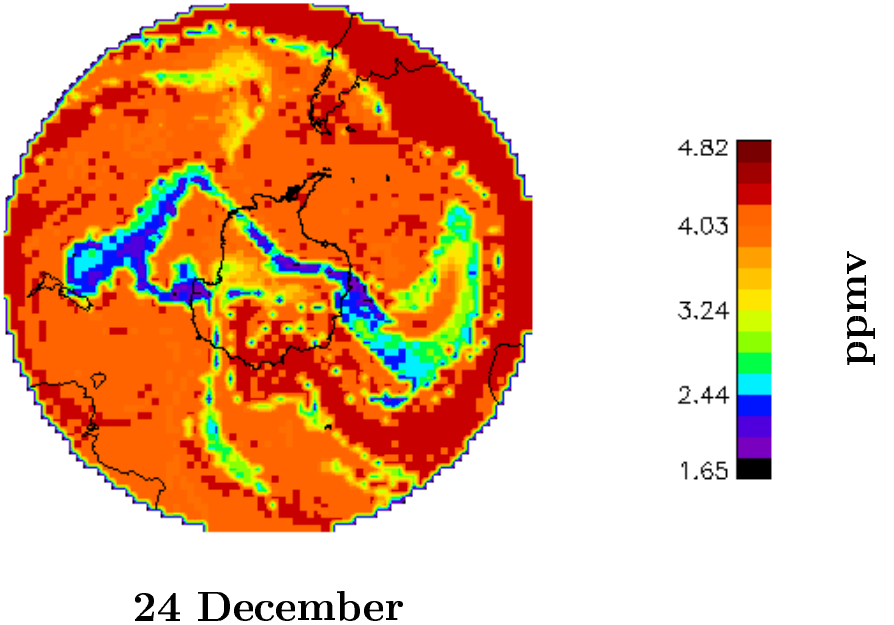
Fig. 5. Polar stereographic (30–90 ◦ S) high-resolution ozone map on the 600K surface, on 24 December 1998. vortex was still intact and the vortex properties were well defined (e.g. PV value of the vortex edge). On the other hand, by choosing 7 December as opposed to some earlier date, the RDF trajectories were not run for longer than 19 days. Nevertheless, as a test of sensitivity to the initial date, all the calculations were additionally performed by using 5 December and 9 December as the initial